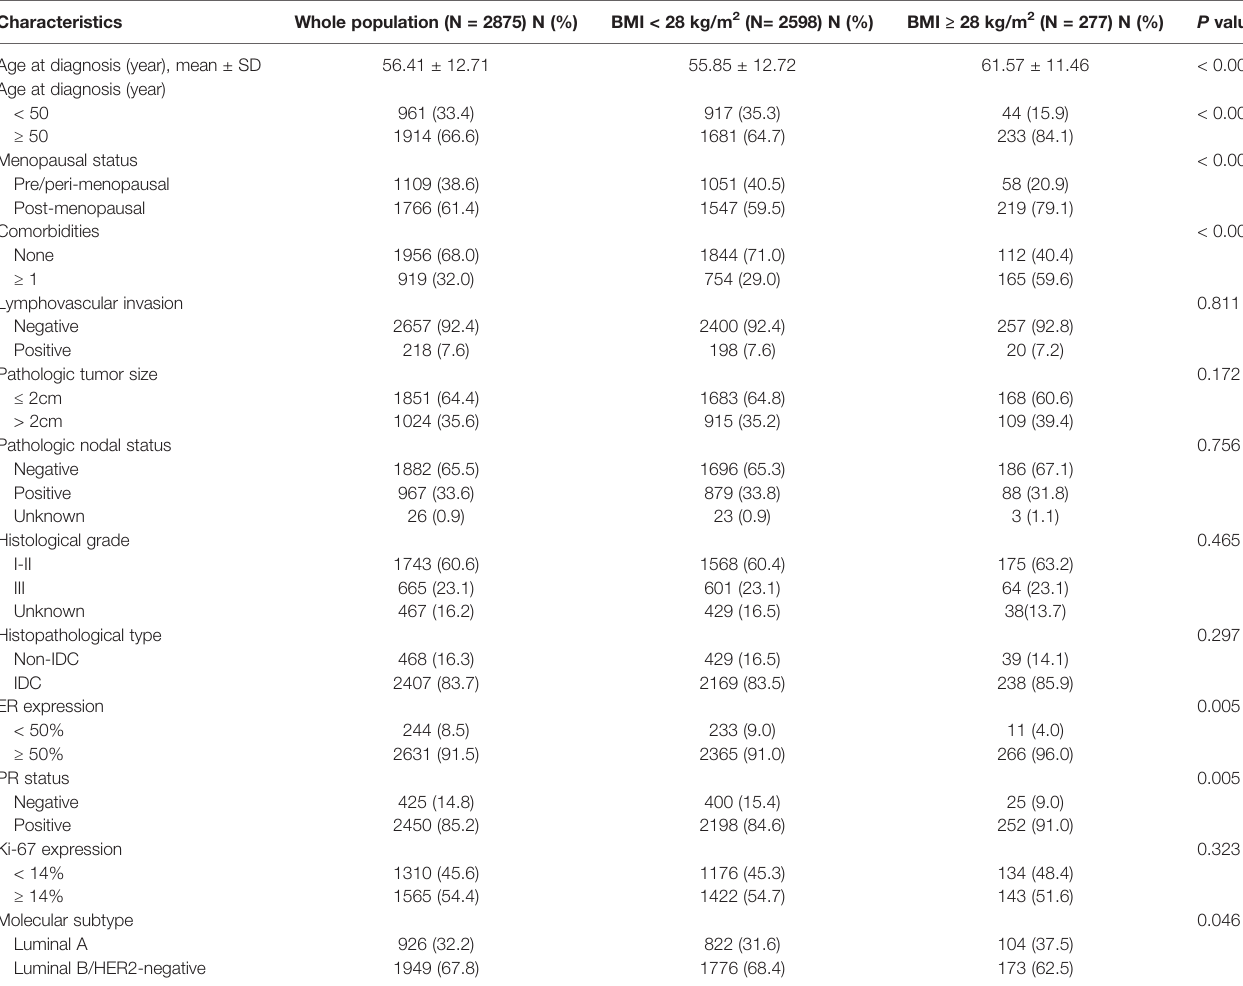
TABLE 1 | Distribution of clinicopathological characteristics in the whole population and different BMI groups.